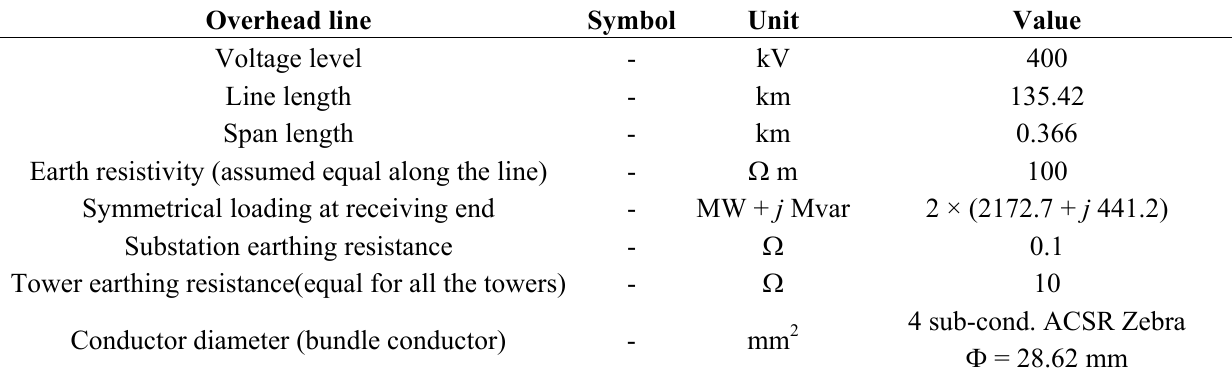
Table 3. Data assumed in the MCA for double-circuit